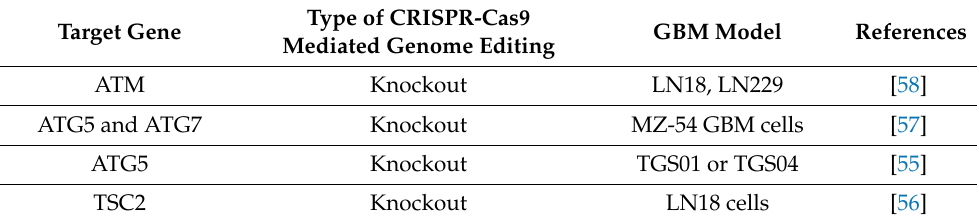
Table 2. CRISPR-Cas9 mediated knockouts of autophagy genes in